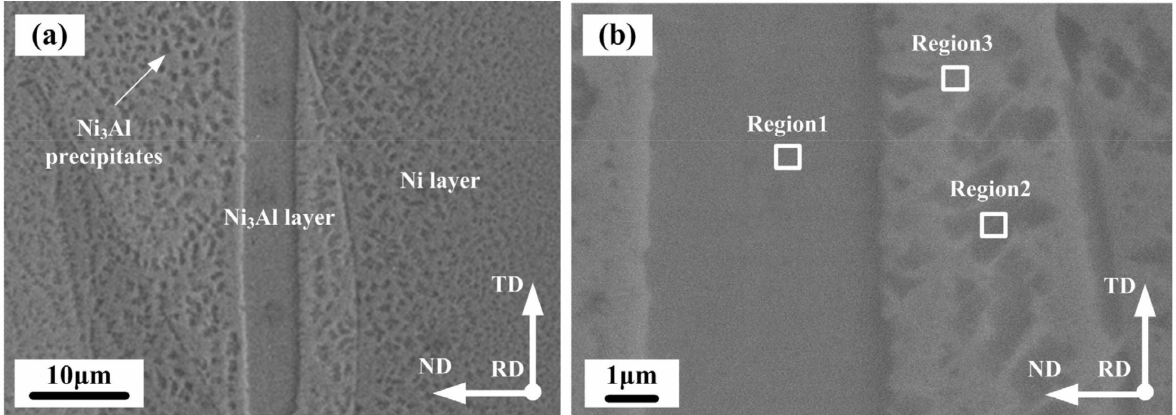
Figure 3. Low-magnification SEM image ( a ) and high-magnification SEM image ( b ) of the laminated composites after hot pressing under 620 ◦ C/5 MPa/1 h + 1150 ◦ C/10 MPa/2 h. RD, ND, and TD are the rolling, normal, and transverse directions,